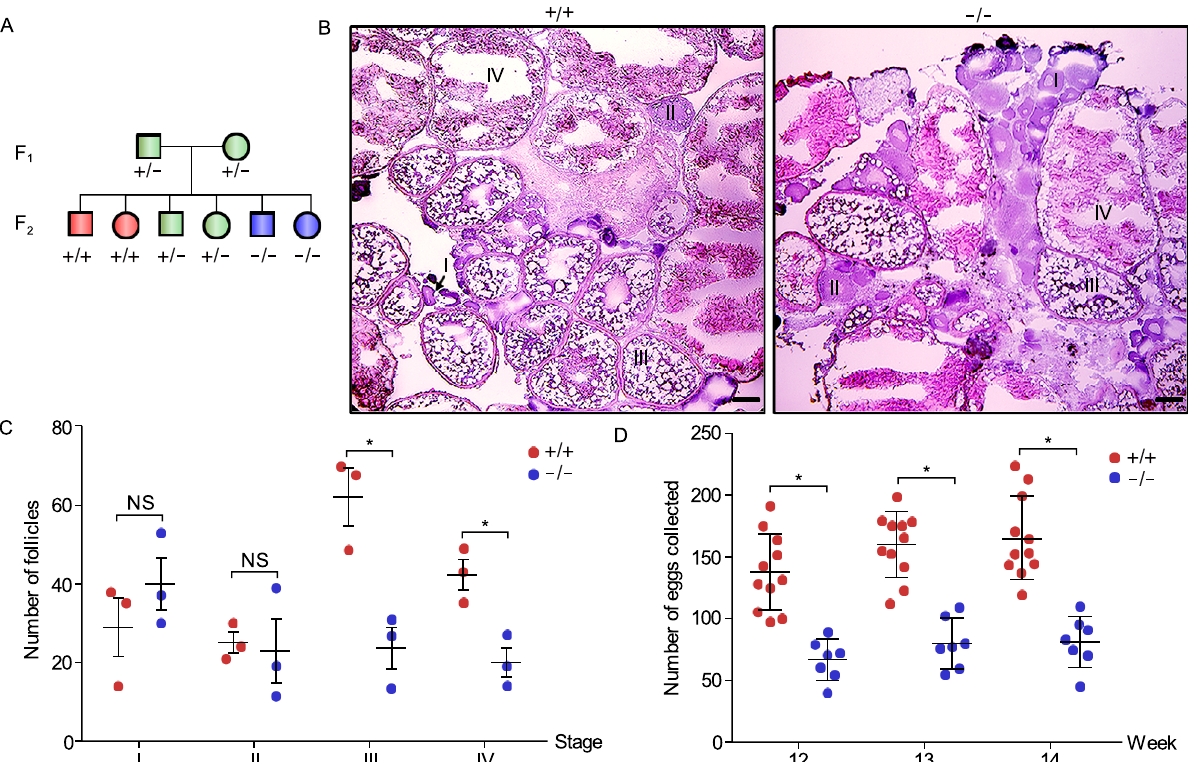
Figure 2. Knockout of sox3 leads to follicle development retardation and a reduced fecundity in female zebra fi sh. (A) Schematic diagram of heterozygote incrosses. All data are from the progeny derived from heterozygote incrosses. WT, +/+; heterozygotes, +/ − ; homozygotes, − / − . (B) Histological analysis of adult ovaries of sox3 +/+ and sox3 − / − by H.E. staining. I, primary growth stage; II, cortical alveolus stage; III, early-vitellogenic stage; IV, late-vitellogenic stage. Scale bar, 50 μ m. (C) Statistic analysis of different stages of follicles from 10 sections for each ovary of sox3 +/+ and sox3 − / − ( n = 3 fi sh per genotype). Data represent means ± SEM. T-test was performed. * P < 0.05; ** P < 0.01. NS, not signi fi cant. (D) Impaired fecundity in sox3 − / − . Statistical analysis of the numbers of eggs produced by sox3 − / − incrosses or sox3 +/+ incrosses at 12-, 13- and 14-week. Data represent means ± SEM. T-test was performed. * P <